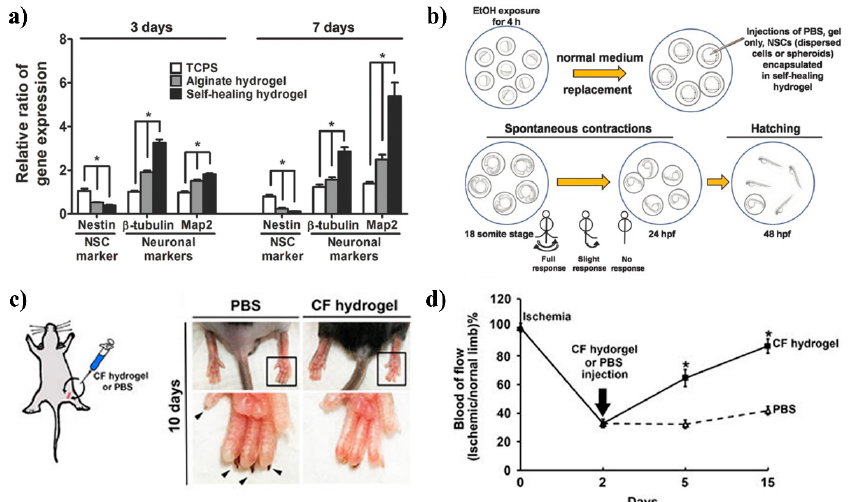
Figure 6. ( a ) The expressions of specific neuronal-related genes in the TCPS, alginate hydrogel and self-healing hydrogel; ( b ) the treatment procedure for central nervous system rescue in zebrafish by the self-healing hydrogel. Firstly, ethanol exposure of the developmental zebrafish embryos resulted in the central nervous system deficits. The medium was then replaced with fresh normal medium following various treatments including PBS, NSC spheroid-laden hydrogel, NSC-laden hydrogel, only hydrogel, and NSC dispersed hydrogel. The spontaneous contraction of the embryos examined at 18 somite stage. Reprinted with permission [42]. Copyright 2015, Wiley-VCH; ( c ) the left femoral artery and iliac artery in mice were cut to induce hindlimb ischemia. The right part shows representative images of mouse ischemic hindlimbs after injection with PBS or CF hydrogel. The arrow indicated nail loss; and ( d ) the significant blood flow increased on 5 and 15 days post-surgery in the CF hydrogel-injected group much higher than those in the PBS-injected group. Reprinted with permission [43]. Copyright 2017, Nature Publishing